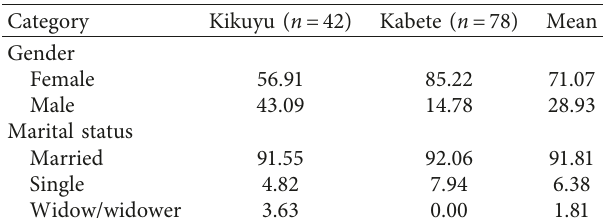
Figure 2: Age of farmers in the study area. Table 1: Gender and marital status of respondents in the study area